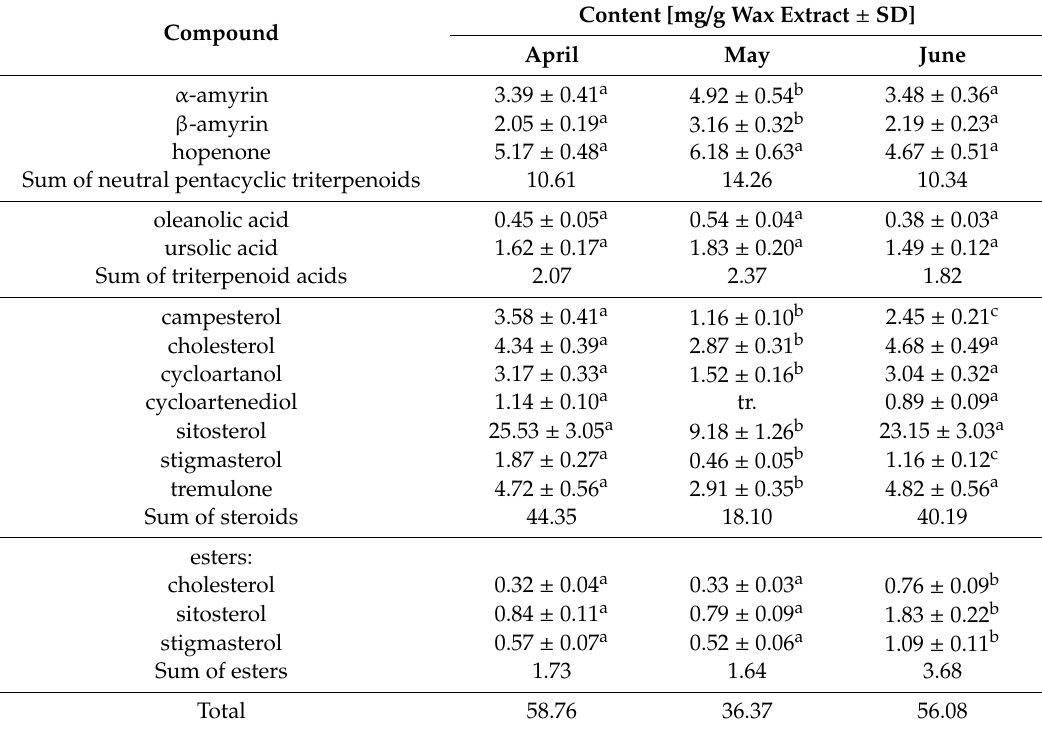
Table 4. Content of triterpenoids in cuticular waxes during edible honeysuckle Lonicera caerulea fruit